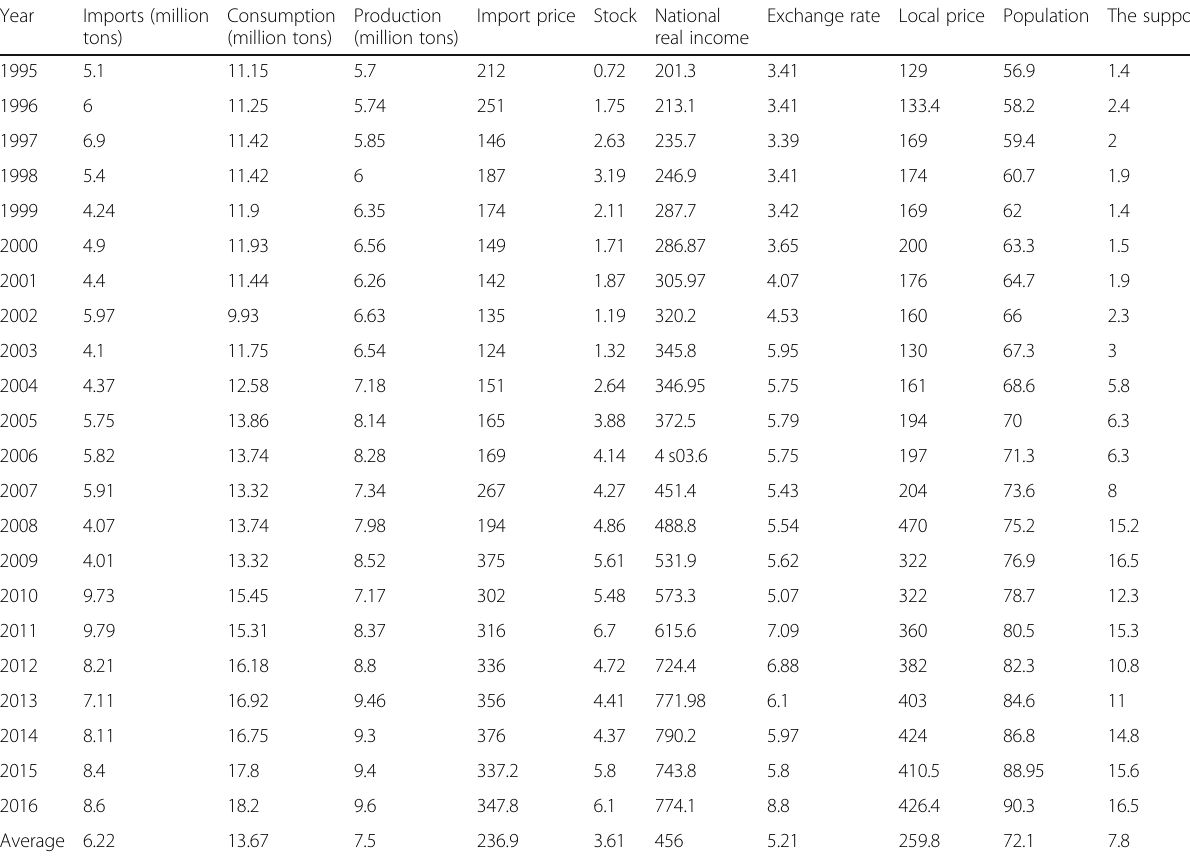
Table 1 Imports, consumption, and production of Egyptian wheat and factors affecting the period (1995 –